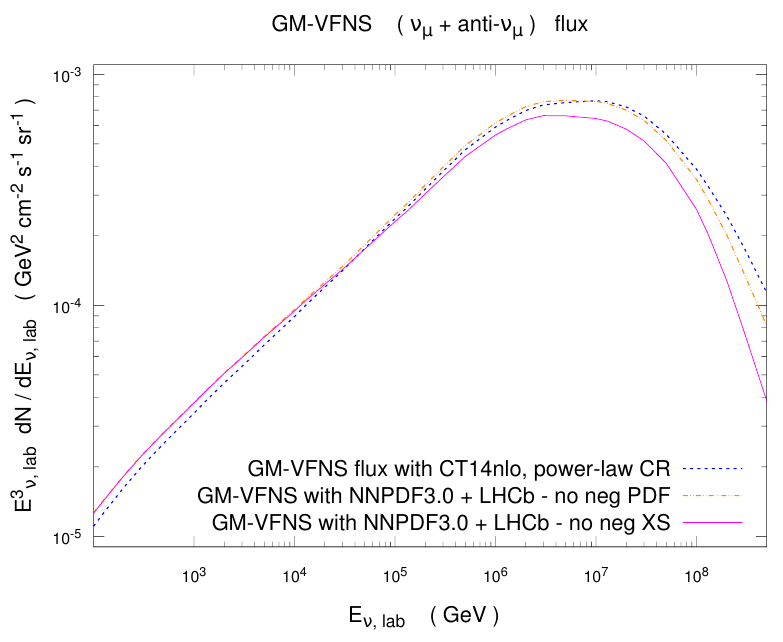
Figure 21 . Prompt-( (cid:23) (cid:22) + (cid:22) (cid:23) (cid:22) ) (cid:13)uxes as a function of neutrino energy E (cid:23); lab . Our standard predictions are compared with those obtained using NNPDF3.0 + LHCb with two prescriptions for the treatment of negative values (no negative PDFs vs. no negative cross sections) as explained in the text.